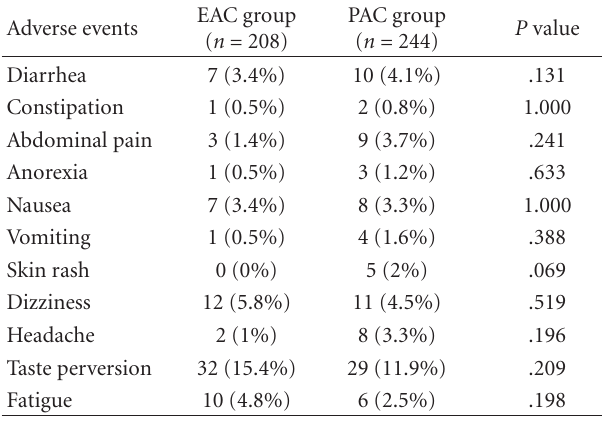
Table 3: Adverse events during single-dosed esomeprazole- and pantoprazole-based triple